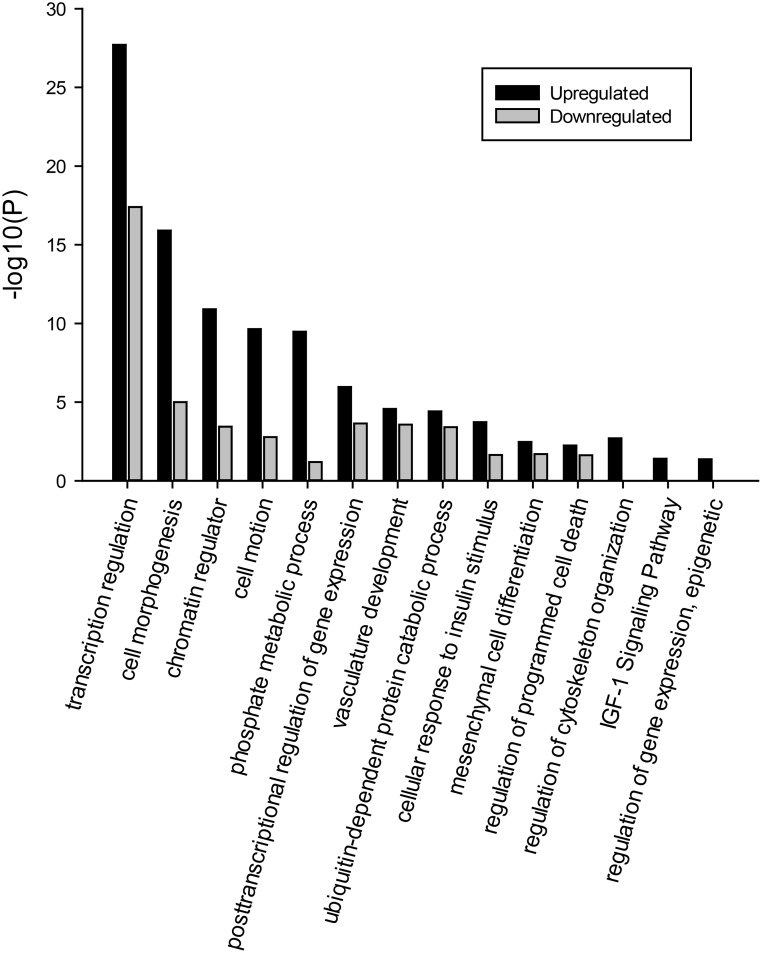
Enriched biological pathways of genes targeted by 33 up-regulated and down-regulated miRNAs with significantly differential expression level.Y-axis shows the significance level of enrichment after Bonferroni adjustment.